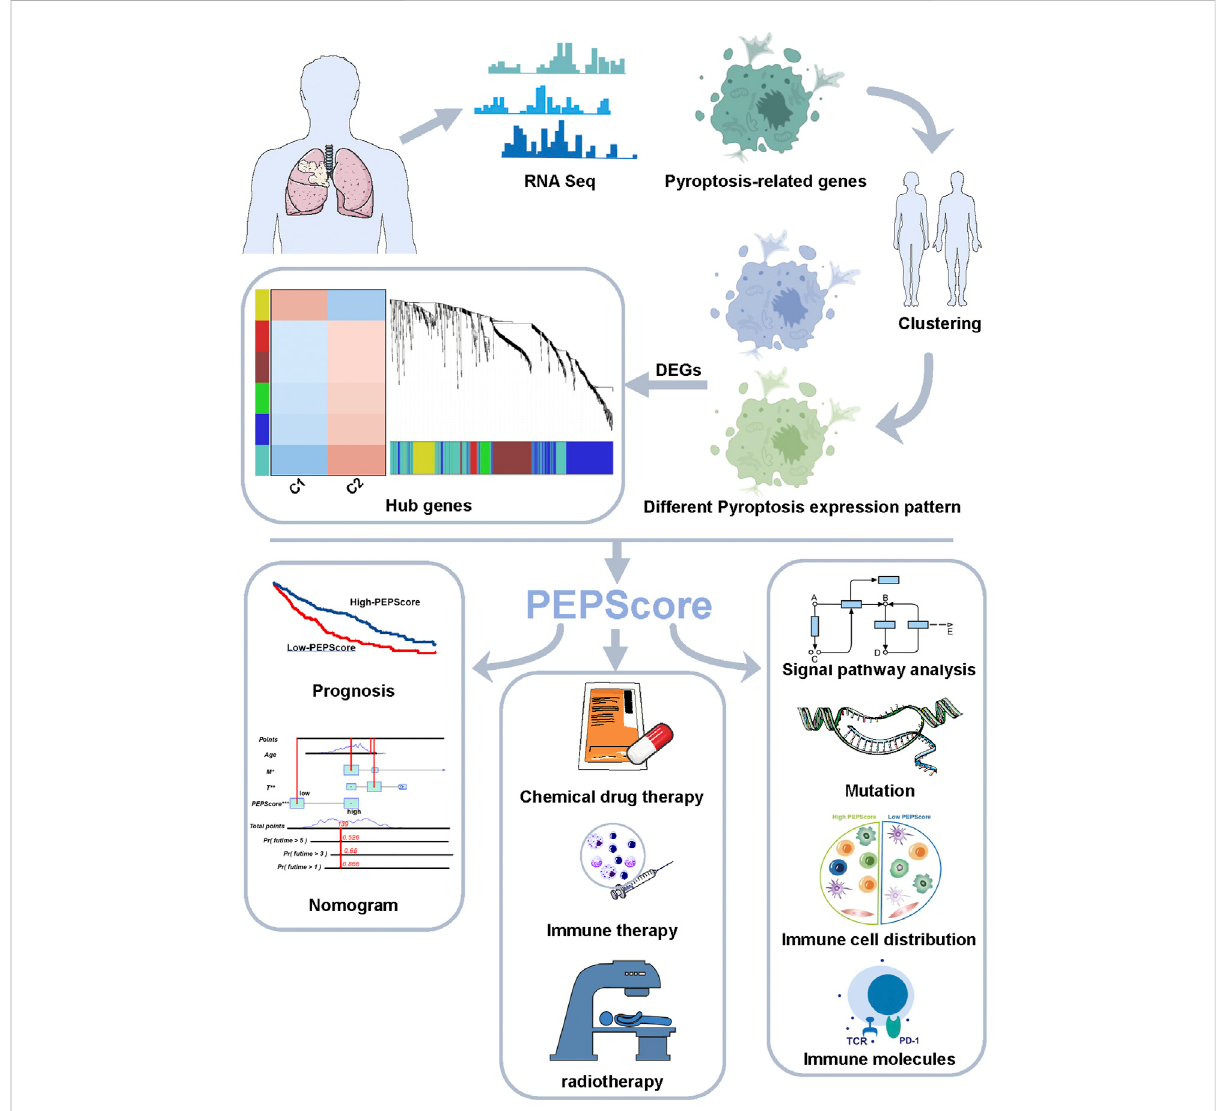
FIGURE 1 Abstract graphical representation for comprehensive characterization of PEPScore subgroups in